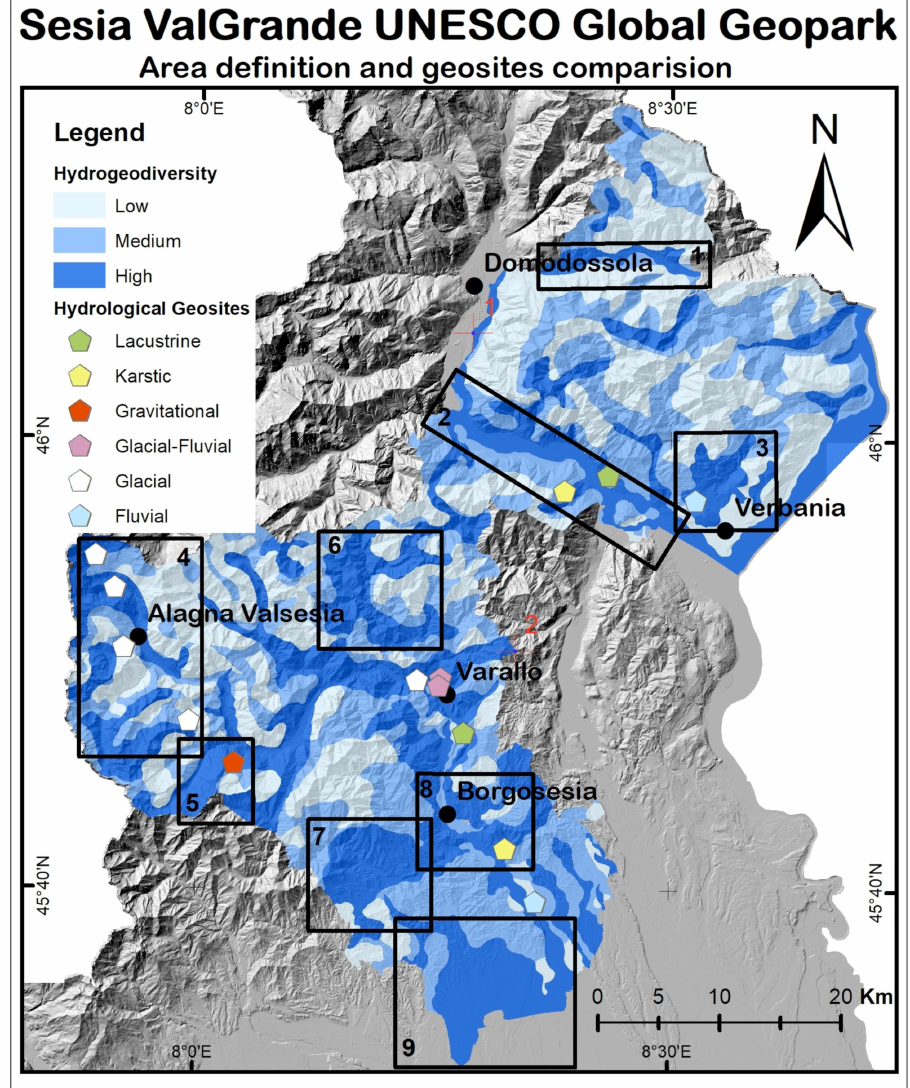
Figure 10. The final solution of the hydro-geodiversity assessment reclassified into three classes with natural breaks in the area definition and hydrogeosites